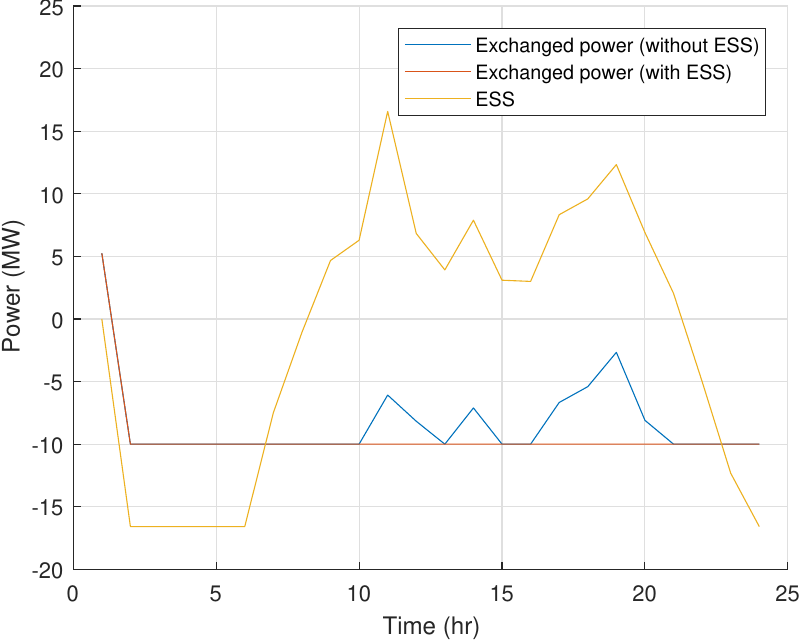
Figure 14. ESS power and exchanged power with negative values.